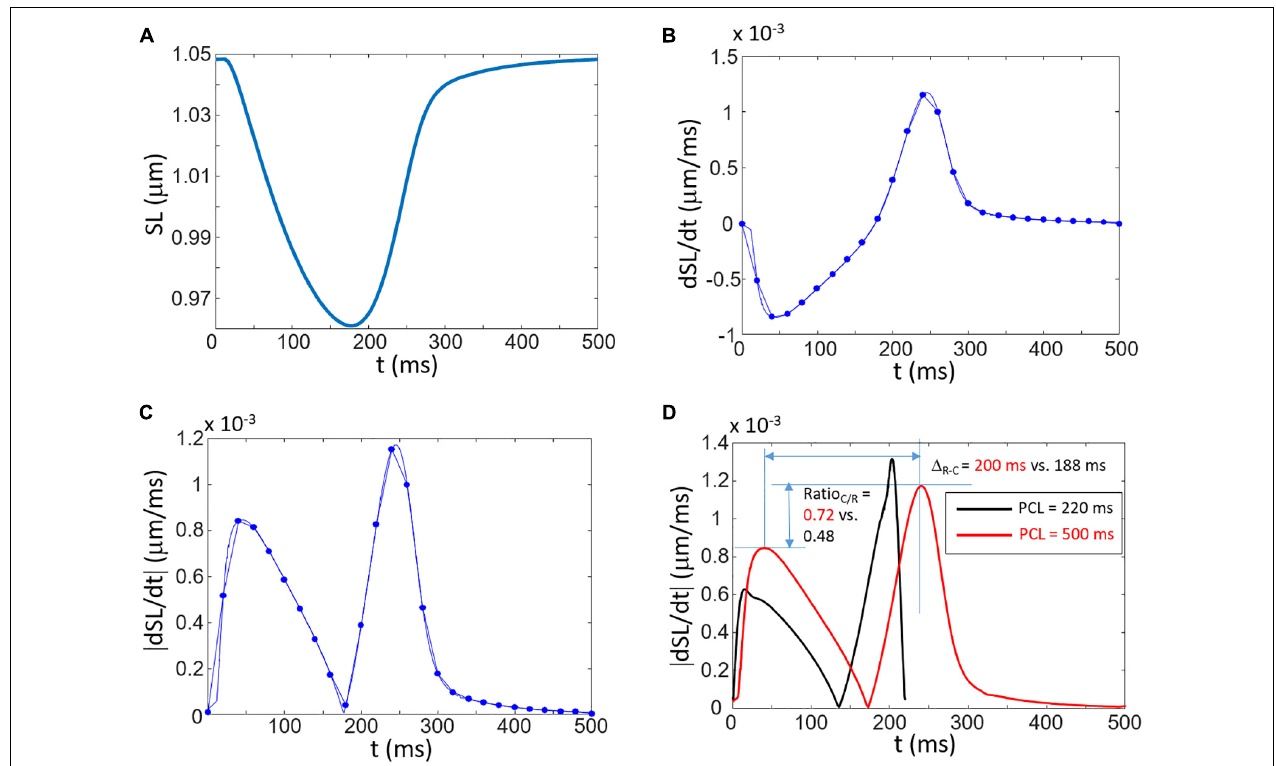
FIGURE 2 | Simulation of contraction and the link to the composite signal (cid:49) S. (A) Shortening of the sarcomere length (SL) as a function of time. (B) The time derivative of SL. The dots correspond to the derivative calculated with a sub-sample signal corresponding to 50 samples/s ( (cid:49) t = 0.02 s). (C) Rectified signal of (B) showing double peaks corresponding to the contraction and relaxation phases. (D) Explanation of two specific measures ( (cid:49) R - C and Ratio C / R ) obtained from simulations at two difference PCL (black curve: PCL = 220 ms; red curve: PCL = 500 ms). A shorter PCL leads to a decreased (cid:49) R - C and decreased Ratio C / R .